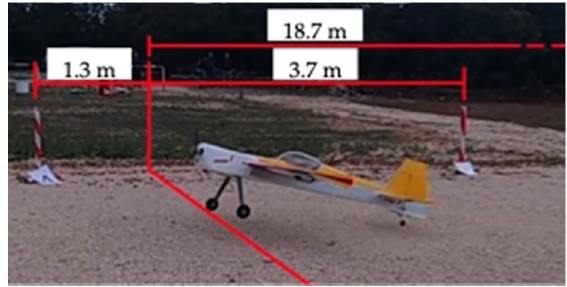
Figure 19. Runway length at first takeoff time.